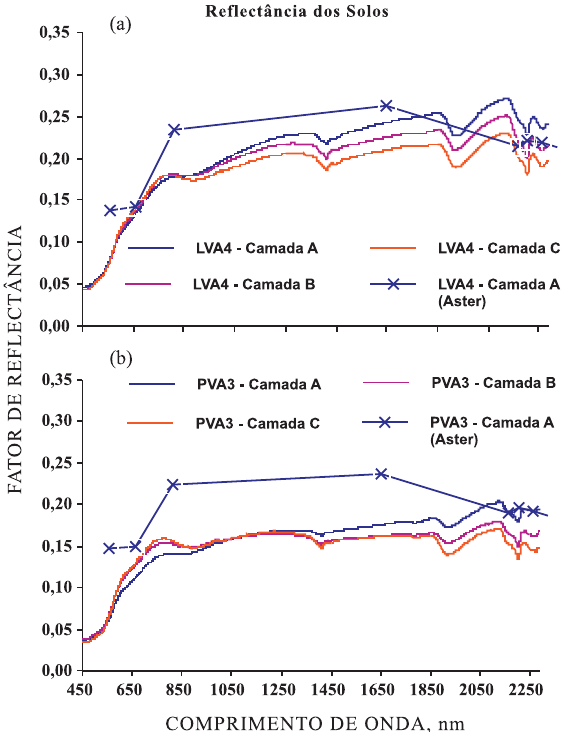
Figura 6. Comportamento espectral de diferentes classes de solos, em superfície (ASTER e FieldSpec) e em subsuperfície (FieldSpec).